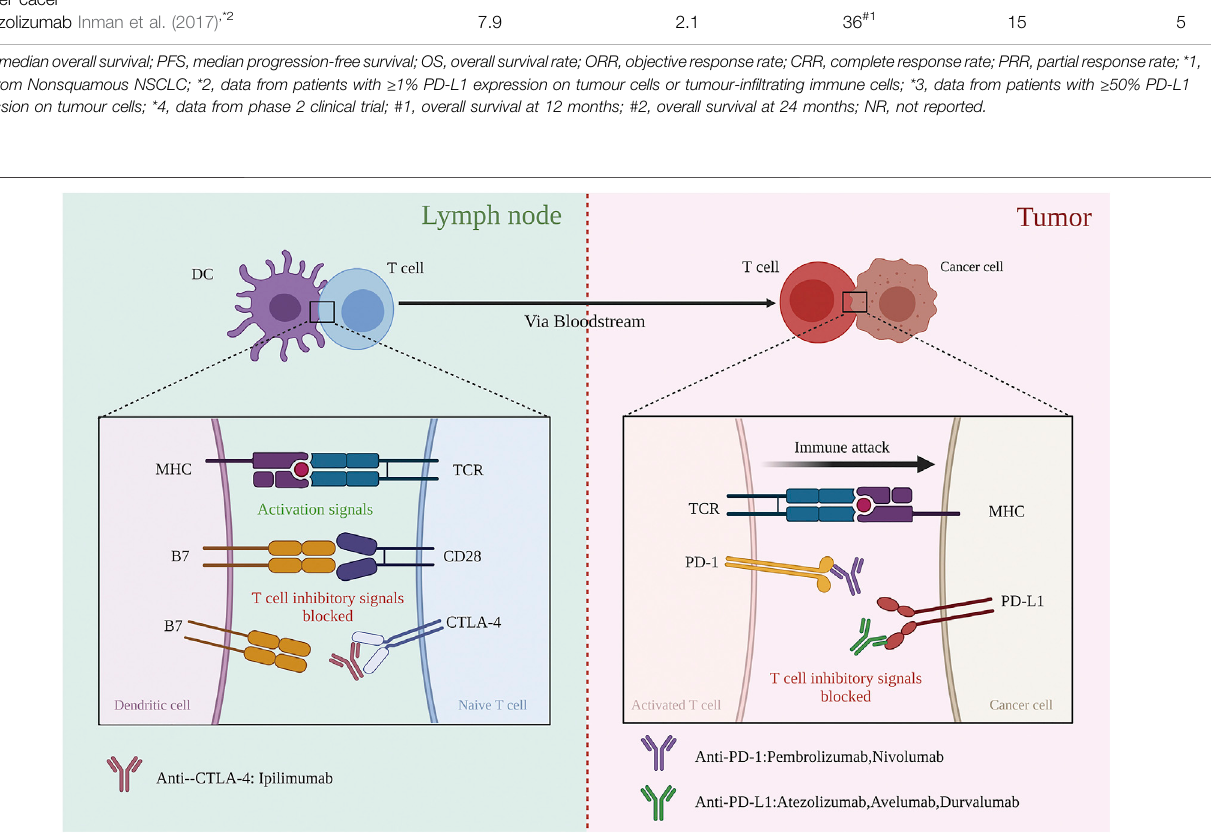
FIGURE 1 | Blockade of CTLA-4 and PD-1 and PD-L1 to enhance antitumor response. (Left) Co-stimulation that CTLA-4 negatively regulates is required for initial activation of CD8 T cell during recognition of its speci fi c tumour antigen, presented by an antigen-presented cell in the lymph node. Blocking CTLA-4 by anti-CTLA-4 antibodies could restore the intensity of co-stimulation. (Right) Activated CD8 T cells migrate to the tumor side based on recognizing speci fi c tumor antigens expressed on the target cancer cell. Once recognized, the antitumor T cell responsegets weak, with T cells expressing PD-1 and target cells expressing PD-L1. The negative regulation could be blocked by anti-PD-1 or anti-PD-L1